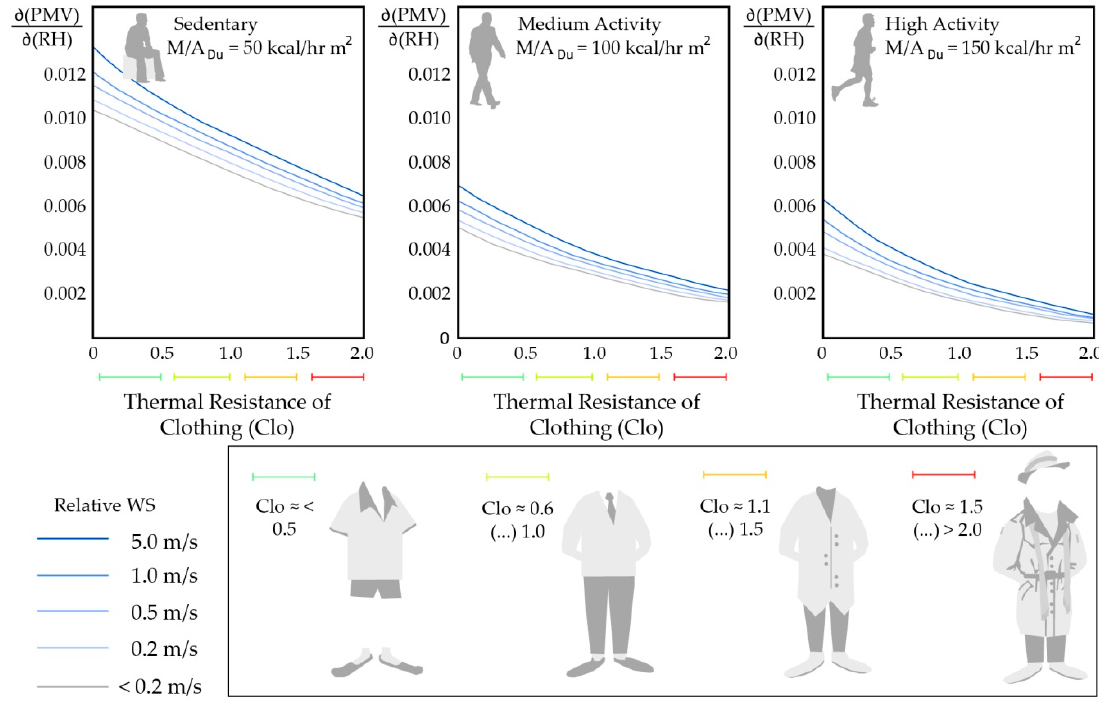
Figure 2. Typical diagrams depicting upon the sensitivity of Predicted Mean Vote and Relative Humidity fluctuation under selected Wind Speed and di ff erent clothing insulation values (Modified from Fanger [91]) and American society of heating refrigerating and air-conditioning engineers [92].